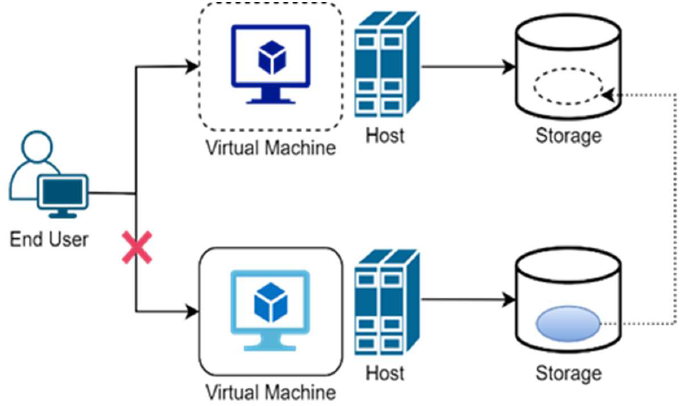
Figure 1. Non-Live Migration.